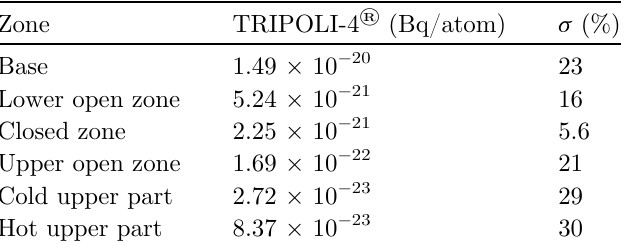
Table 3. Activation values obtained with the TRIPOLI-4 ® code inside the IHX.